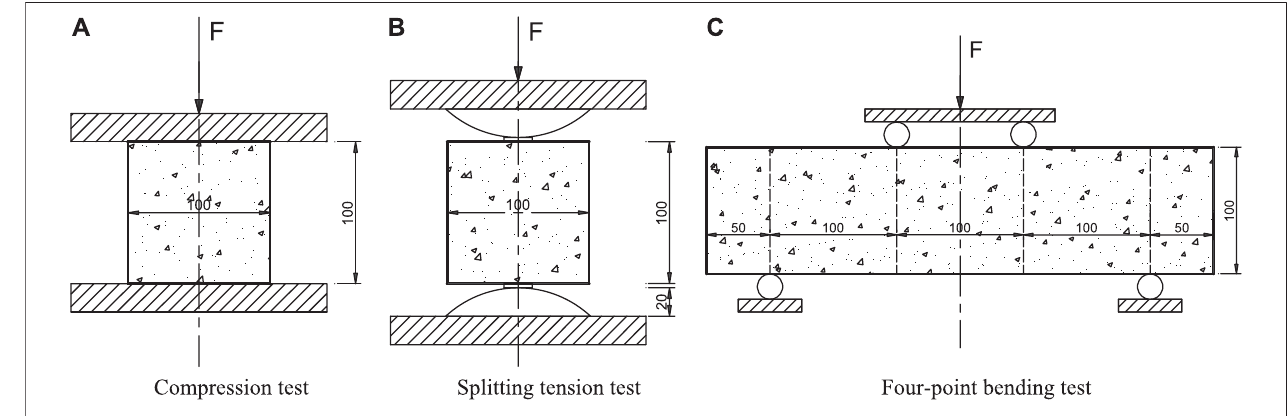
FIGURE 2 | Loading schematic diagram of experiments. (A) Compression test, (B) Splitting tension test, and (C) Four-point bending test.